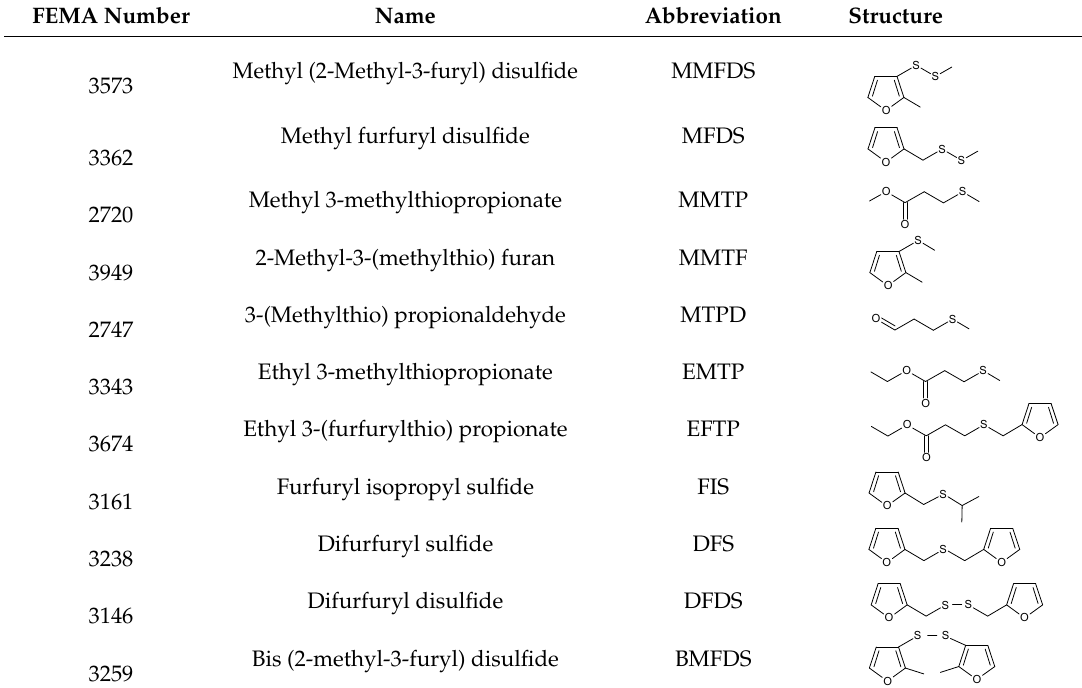
Table 1. Structure of eleven oxygen-containing sulfur flavor molecules.